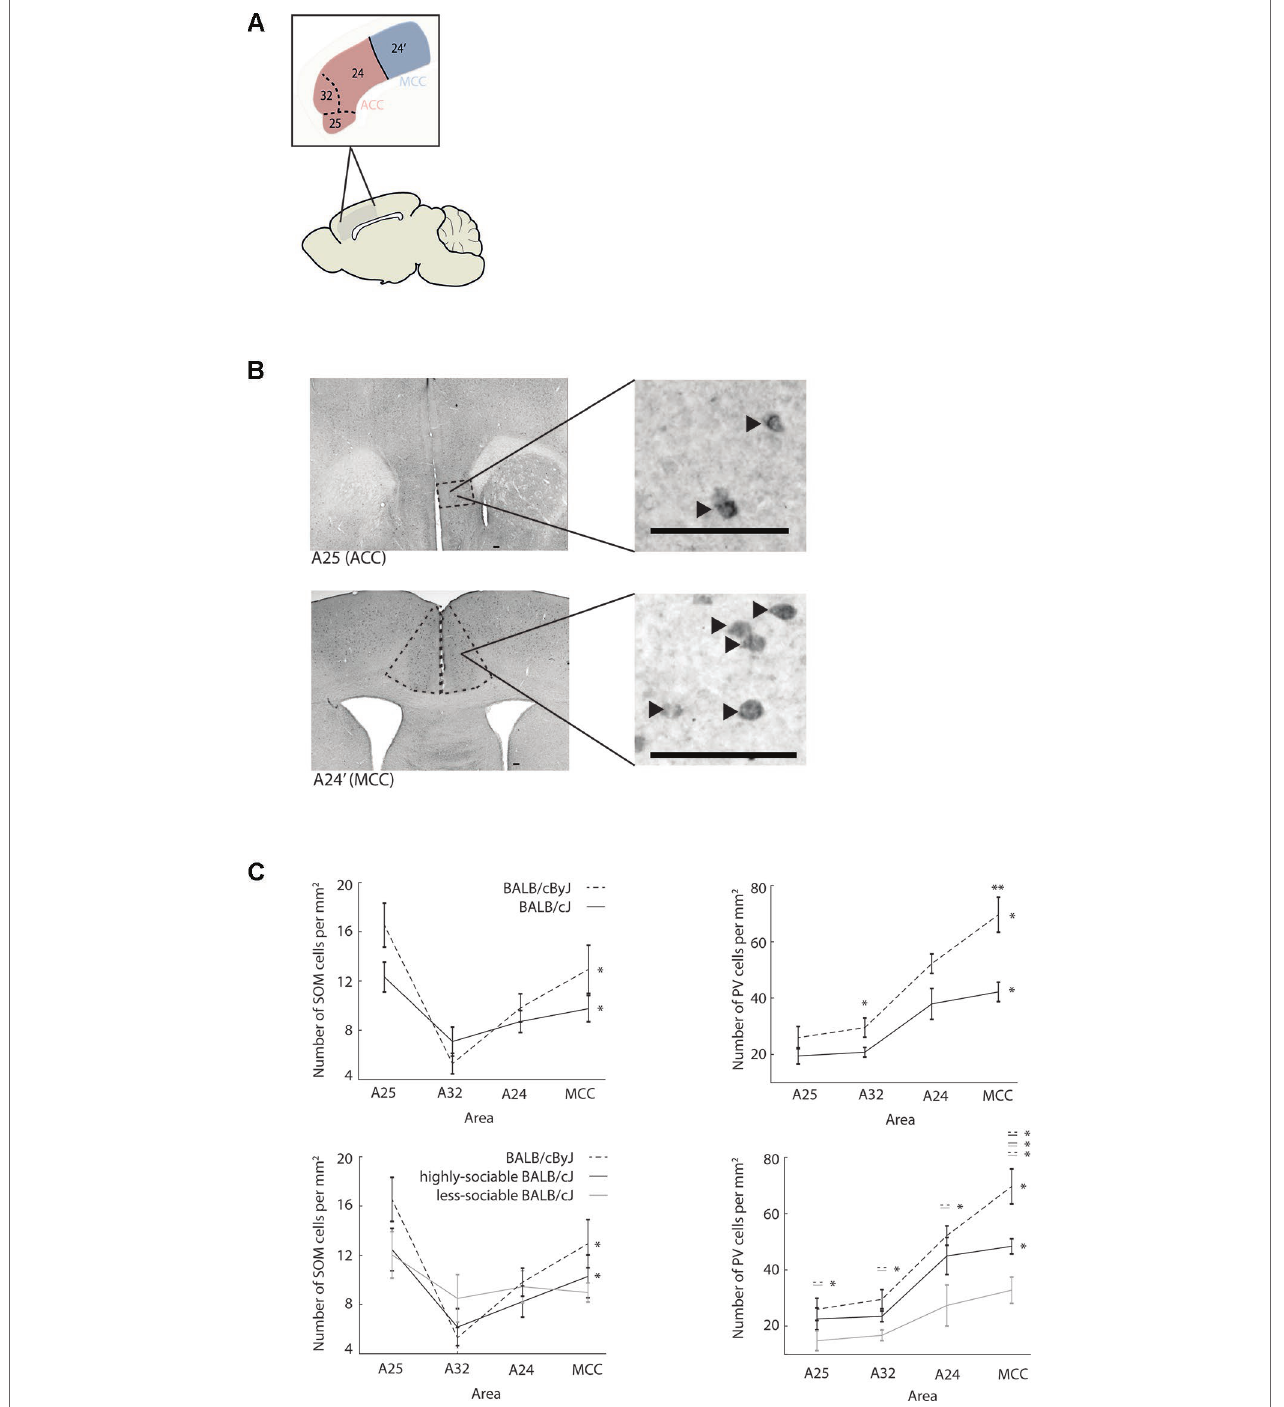
FIGUrE 3 | Interneuron populations across anterior cingulate cortex (ACC) and midcingulate cortex (MCC) (A) Schematic showing the definition of ACC and MCC used in this study. ACC consists of sub-areas A25, A32, and A24. MCC is not divided into sub-areas in the rodent and consists of area A24′ only. Note: the definition used here is homologous to the definition used in higher mammalian species and does not correspond to the cingulate area 1 vs. cingulate area 2 definition. (B) First row: macrographs of somatostatin (SOM) interneurons in A25 of ACC (dashed lines), zoom-in shows higher magnification macrograph of SOM interneurons in A25. Scale bar is 100 µm. Black arrow heads point to stained neurons. Second row: same for parvalbumin (PV) neurons in MCC. (C) First row: distribution of SOM and PV interneurons across ACC and MCC. Left panel: number of SOM interneurons per mm 2 in A25, A32, and A24 of ACC and in MCC. Black line: BALB/cJ mice. Black dashed line: BALB/cByJ mice. Error bars: standard error of the mean (SEM). Right panel: same for PV population. Second row: same as first row but plotted separately for sociable (black line) and less-sociable BALB/cJ mice (gray line). * p < .05; ** p <